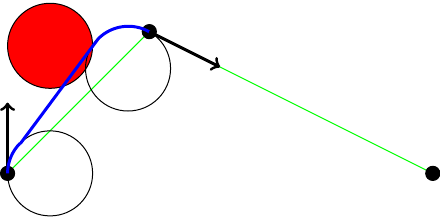
Figure 11. Example of collision with an obstacle after the addition of Dubins curves: the straight line path is drawn in green and is in the free space. The Dubins path is shown in blue and passes though the obstacle in red